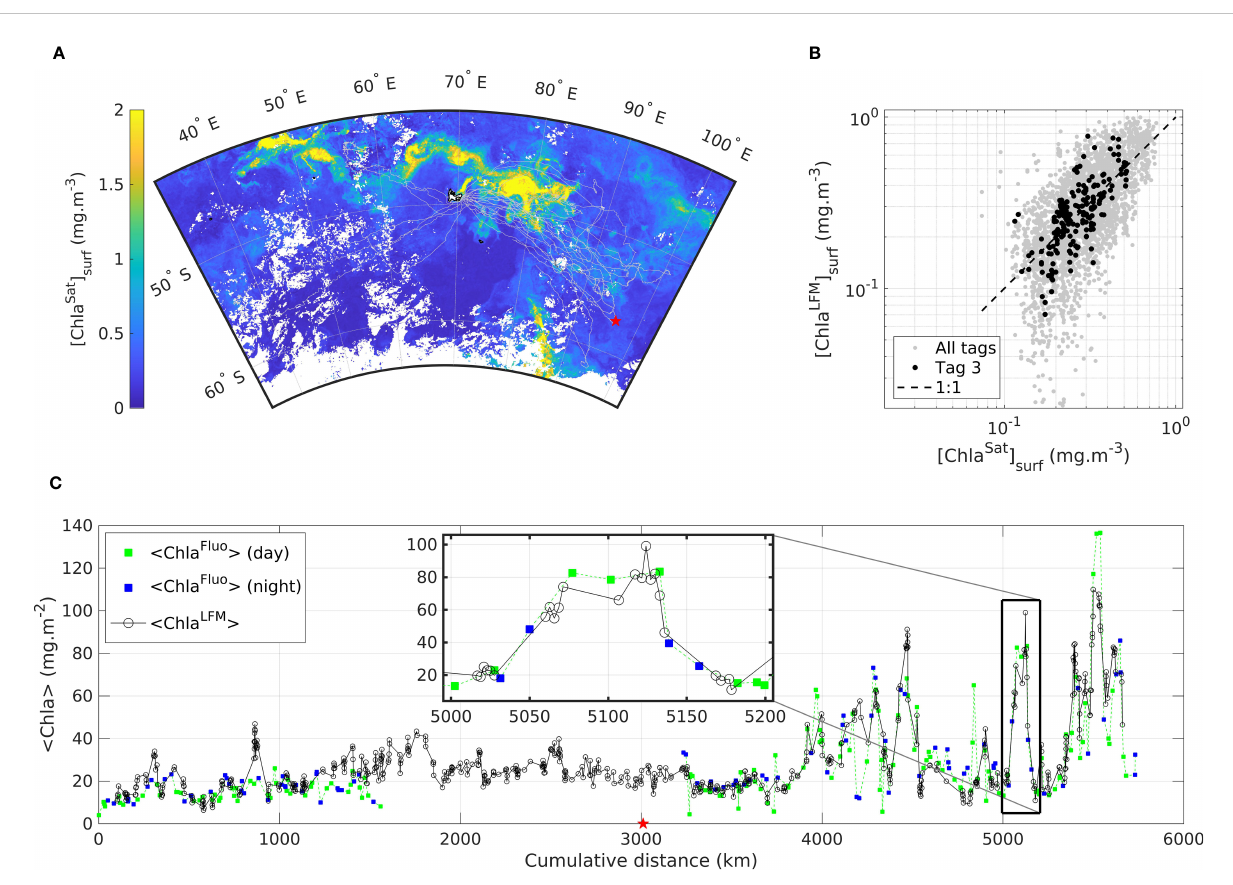
FIGURE 7 Transect of a SES equipped in Kerguelen in October 2019 with SRDL referred to as Tag 3 including (A) a map of the trajectory described by the SES from 25-Oct-2019 to 02-Jan-2020 departed from- and arrived at Kerguelen (B) comparison of [Chla LFM ] surf with [Chla Sat ] surf for Tag 3 and (C) <Chla> as measured (<Chla Fluo >) and predicted (<Chla LFM >) along the transect of Tag 3, where green (blue) squares represent the <Chla Fluo > data measured during the day (night) and black circles represent <Chla LFM >. The inset in (C) highlights the data on a section of the animal transect (~200 km). The red star in (A) and (C) represents the furthest location from Kerguelen in the trajectory of the animal equipped with Tag 3. Light gray dots in (A) and (B) represent the data of all the other tags included in the present study. The dashed black line in (B) represents the 1:1 reference line. The background map in (A) is the climatology of [Chla Sat ] surf derived from GlobColour computed for each pixel as the mean value of [Chla Sat ] surf during the month of November